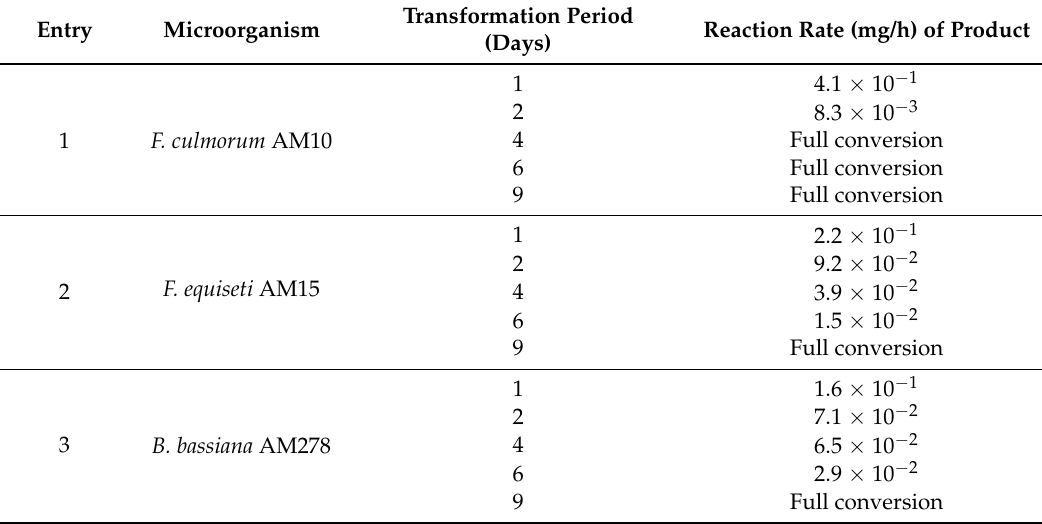
Table 1. The reaction rates of production of hydroxylactone ( 4 ) by selected